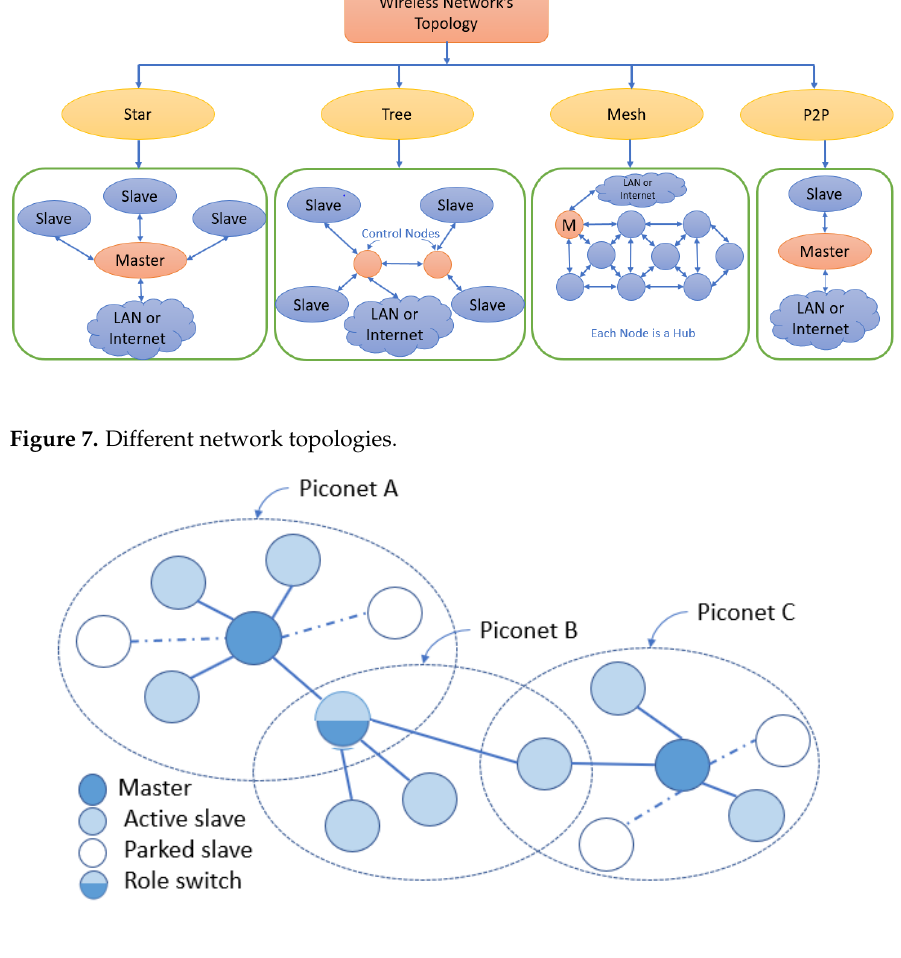
Figure 8. An example of a Bluetooth